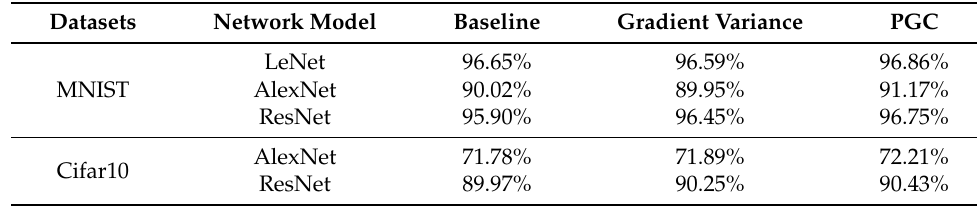
Table 2. The accuracy of all network models.